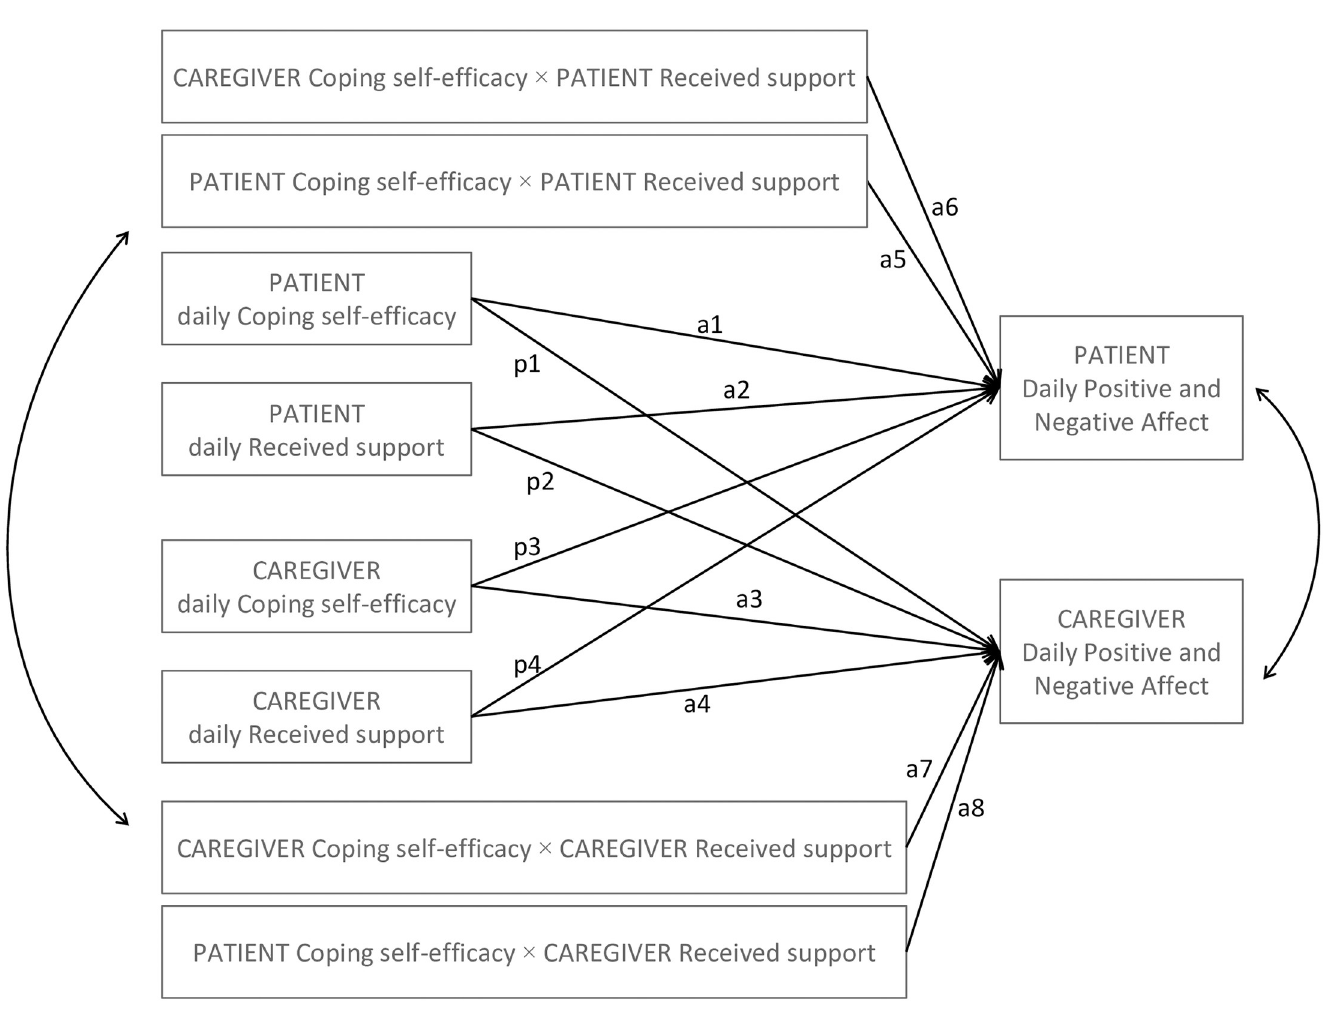
Fig 1. Research model. Note: paths a5-a8 , interaction effects of coping self-efficacy and received support; a1 , a3 , p1 , and p3 , main effects of coping self-efficacy; a2 , a4 , p2 , and p4 , main effects of received support; a and p , actor and partner effects, respectively; covariances between both, predictors and outcomes are symbolically marked with a two-way